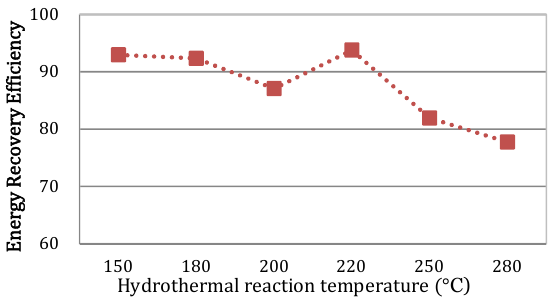
Figure 4. Energy recovery efficiency of cellulose and its biochar after HTC treatment.